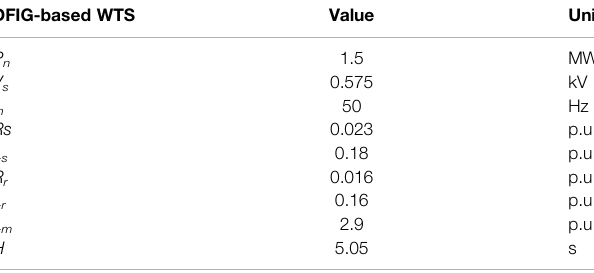
TABLE A2 | Parameters of the doubly-fed induction generator – based wind turbines.